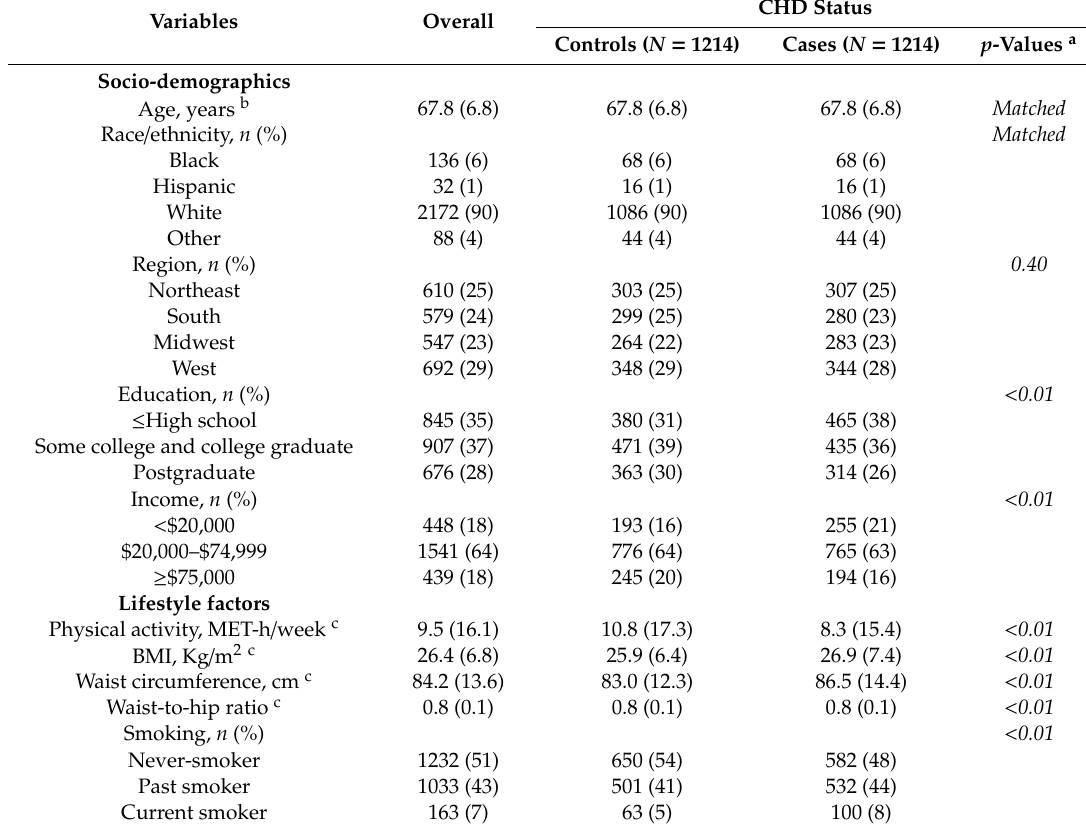
Table 2. Baseline characteristics by cases and controls in the Women’s Health Initiative study (1994–2005) ( N =